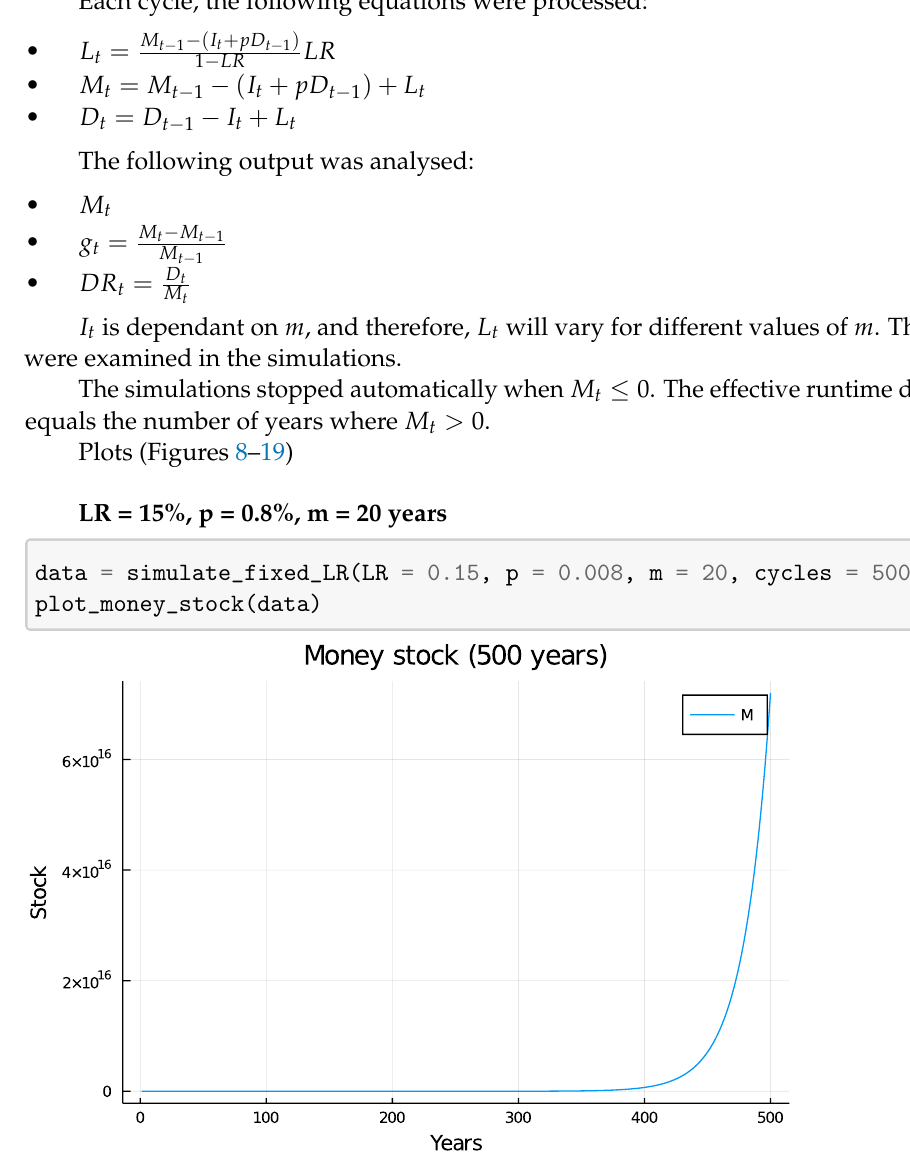
Figure 8. Money stock (LR = 15%, p = 0.8%, m = 20